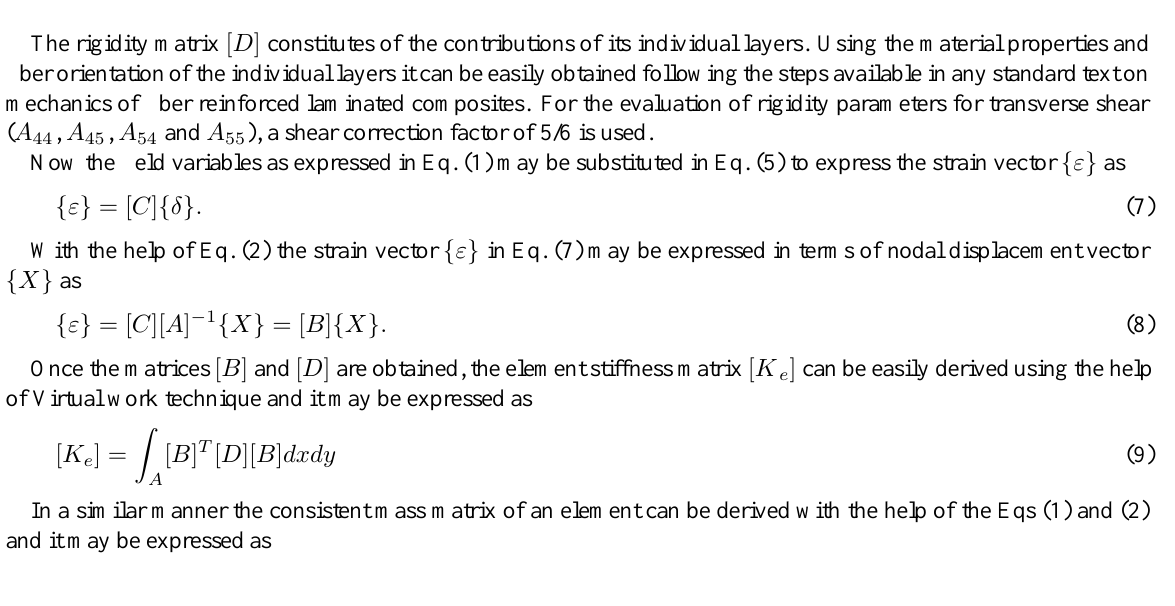
Frequency parameters ( ωa 2